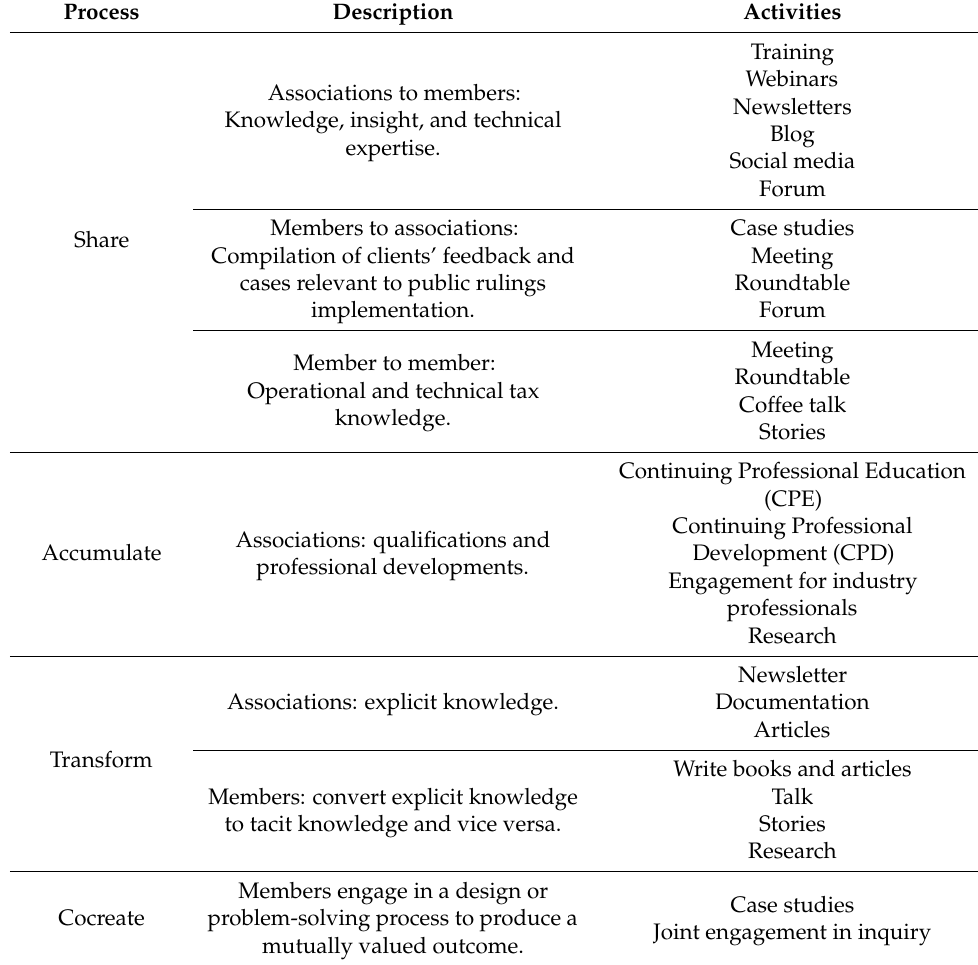
Table 3. List of